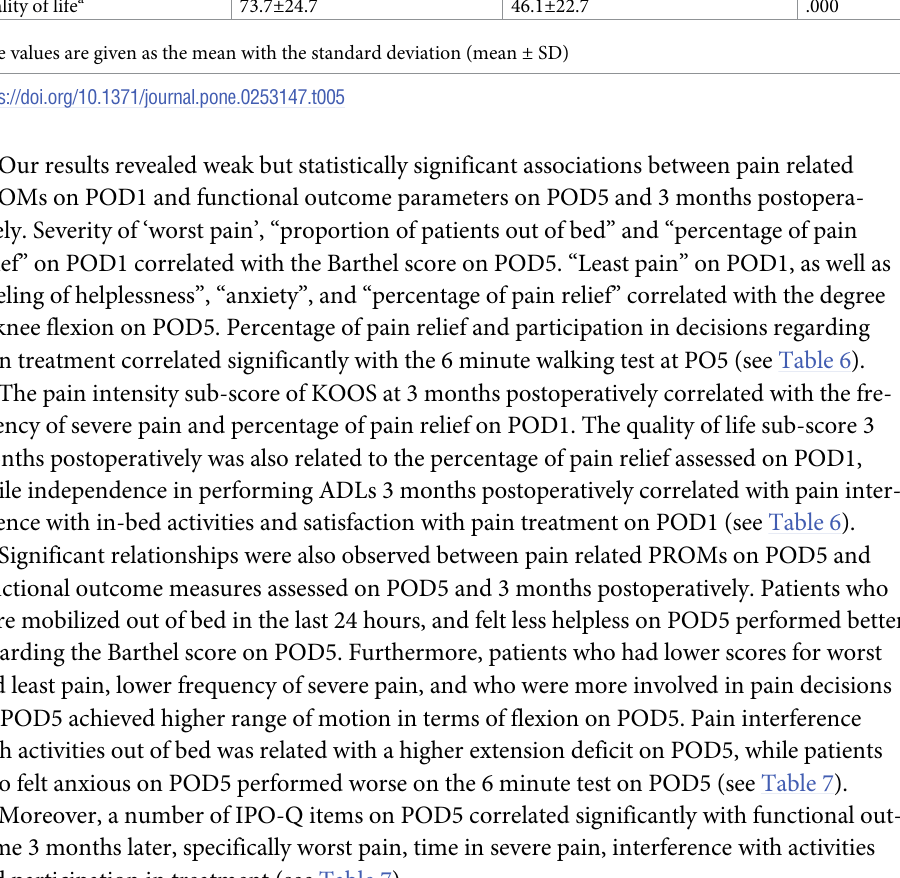
Table 6. Pearson correlation coefficients r between PROMS on POD1 and functional results on POD5 and 3 months after surgery ( � p < 0.05). POD1